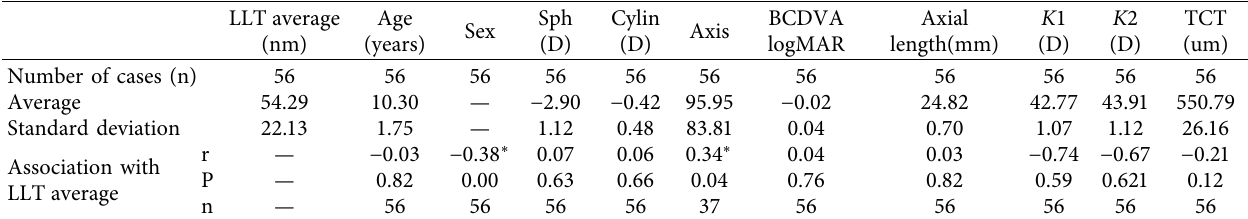
Table 4: Association of LLT average and other variables of 56 orthokeratology eyes at baseline.